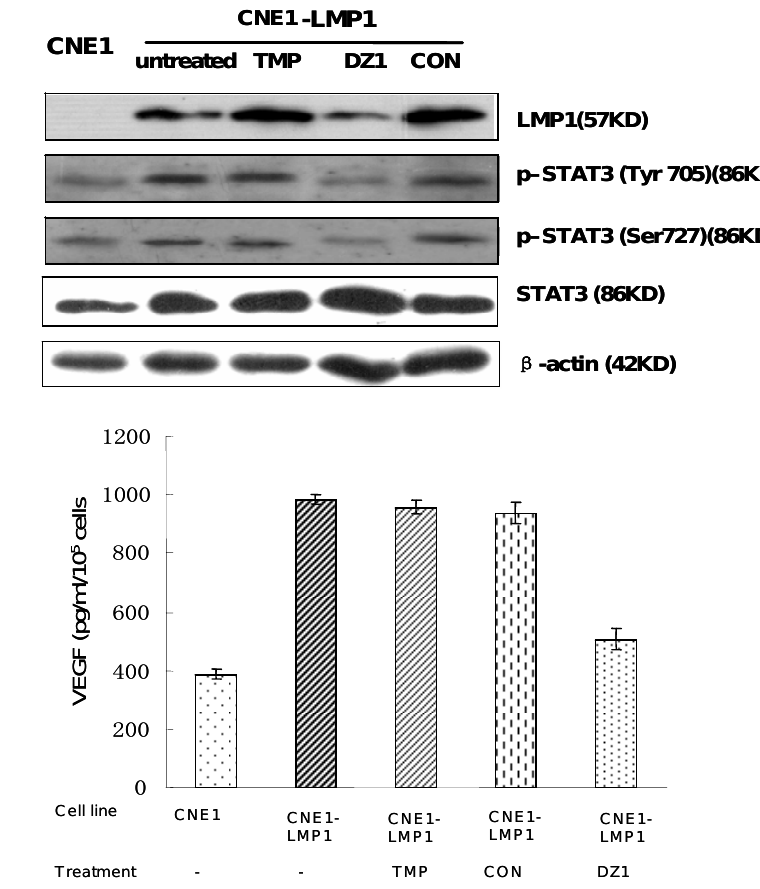
Figure 6. DZ1 suppression of metastasis potential in LMP1 positive NPC cells. A: DZ1 decreased STAT3 phosphorylation. NPC cells were transfected with DNAzyme or controls. After 24 h, LMP1 expression and STAT3 levels was determined by immunoblotting with antibodies specific for LMP1, phosphorylated STAT3 Tyr705 and STAT3 Ser727. B: Soluble VEGF were collected from conditioned medium and quantitatively determined by ELISA. C: Migration assay. The number of cells that had migrated through the pores was quantified by counting five independent visual fields using a 20× microscope objective. Three independent assays were performed. Each point shows the mean